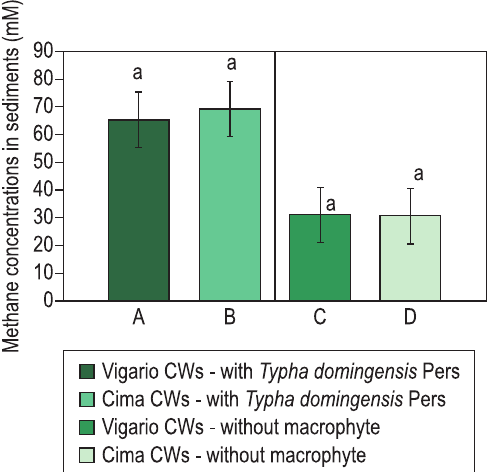
Figure 3. CH concentrations in the sediment of eu- 4 trophic (Lake Vigário) and mesotrophic (Lake Cima) CWs with and without macrophyte. a) Lake Vigário CWs with macrophyte Typha domingensis Pers ; b) Lake Vigário CWs without macrophyte; c) Lake Cima CWs with Typha domingensis Pers ; and d) Lake Cima unplanted plots. For sediments analysis, no were found significant differences among treatments, for each lake separately (Kruskal–Wallis test (95% level of significance) and Dunn´s test (95% of level of